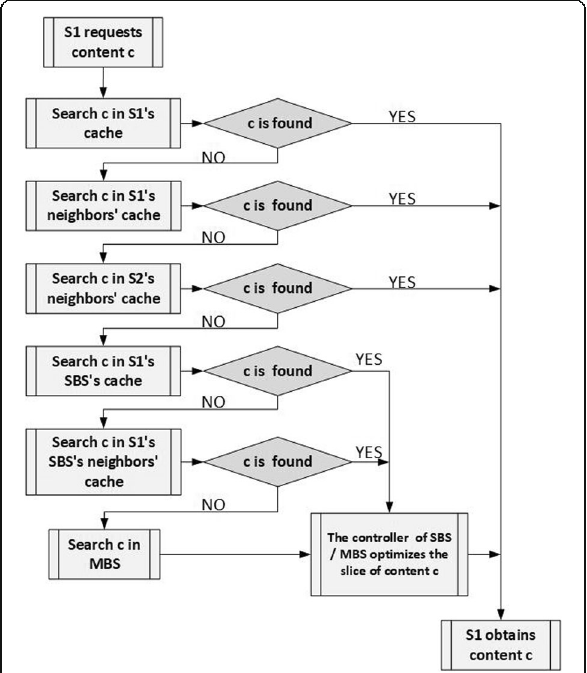
Fig. 8 The process of request and cache decision for content